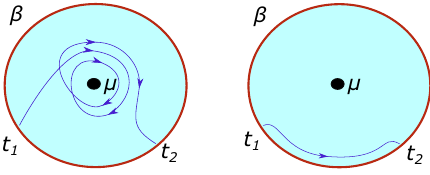
Figure 20 . Winding boundary-anchored Wilson line amplitudes for the path integral (D.12): n = 3 example (left) and n = 0 example (right). Only the case n = 0 calculates the